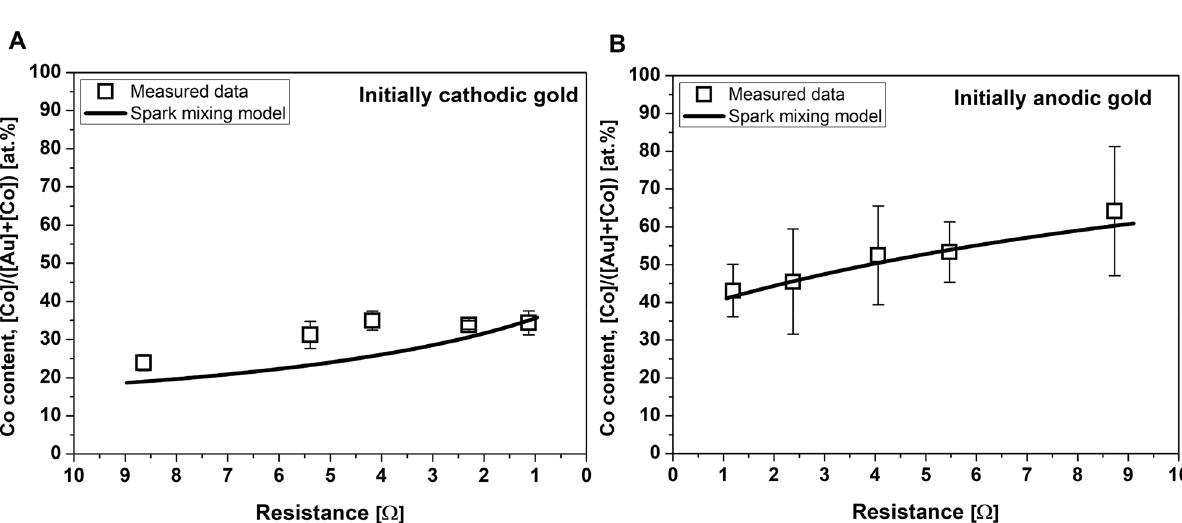
Figure 5. Variation of the composition of the Au/Co/CoO NPs obtained by ICP-MS, as a function of the total resistance of the discharge circuit when gold is initially cathodic ( A ) and anodic ( B ). Error bars indicate the uncertainty of the composition corresponding to a 90% confidence level.